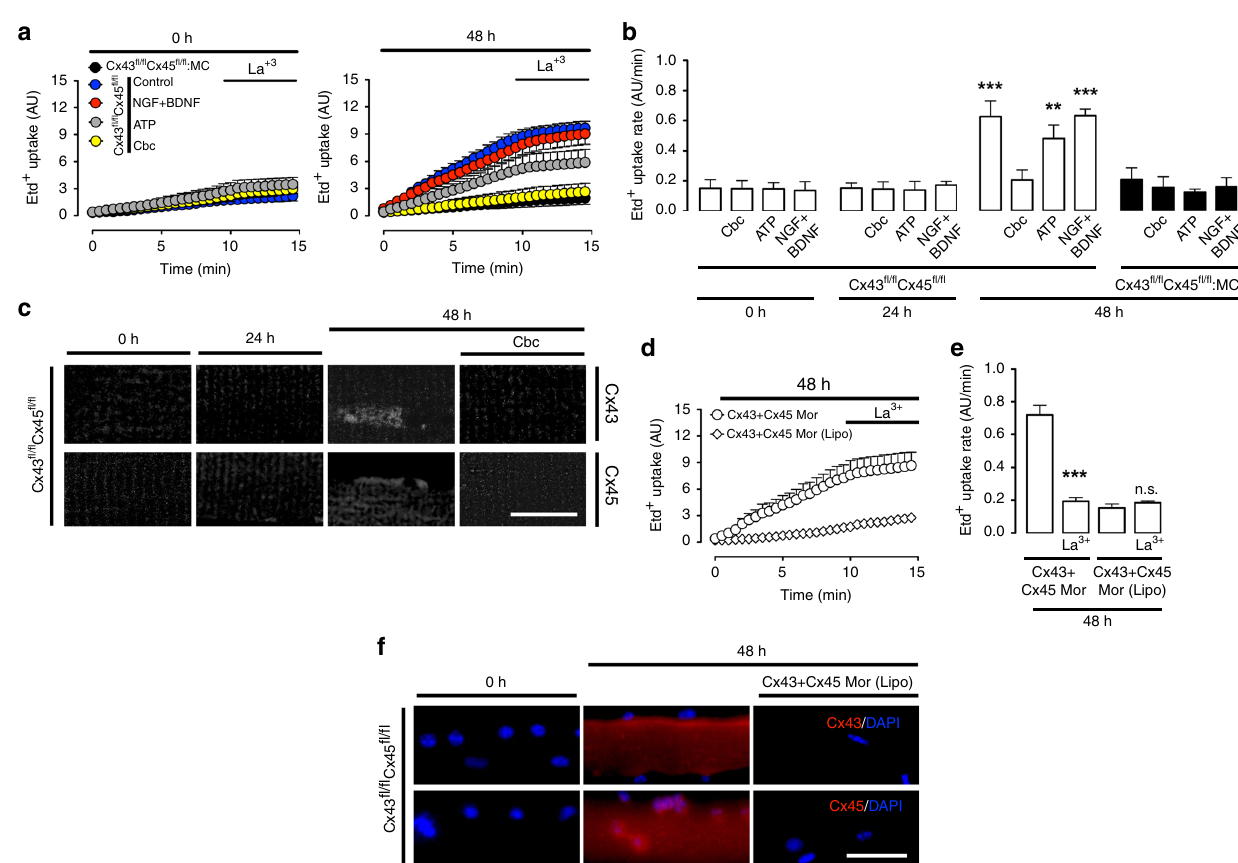
Fig. 5 Acetylcholine analogs repress the expression of connexin hemichannels, which leads to atrophy in denervated skeletal muscles. Primary cultures of myo fi bers from fl exor digitorum brevis muscles of Cx43 fl / fl Cx45 fl / fl and Cx43 fl / fl Cx45 fl / fl :Myo-Cre (Cx43 fl / fl Cx45 fl / fl :MC) mice were used. a Membrane permeability was evaluated in ethidium (Etd + ) uptake experiments at 0 h (left) or 48 h (right) of culture. The fi rst 10 min are baseline, after which myo fi bers were treated with 200 μ M La 3 + . The sarcolemmal permeability of myo fi bers from Cx43 fl / fl Cx45 fl / fl was measured in culture under control conditions (blue circles), or in the presence of 50 ng/mL NGF + 50 ng/mL BDNF (NGF/BDNF; red circles), 500 µ M ATP (gray circles), or 200 nM Cbc (yellow circles). Myo fi bers of Cx43 fl / fl Cx45 fl / fl :MC mice were cultured under control conditions (black circles). b Etd + uptake rate of myo fi bers. N = 4; fi